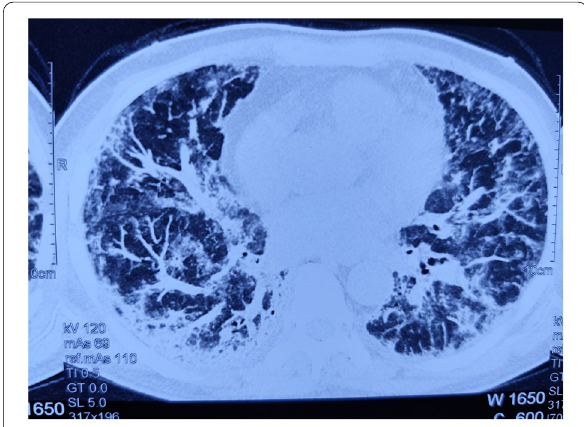
Fig. 1 HRCT-Chest showing diffuse areas of ground glass opacities with interlobular septal thickening in bilateral lung fields